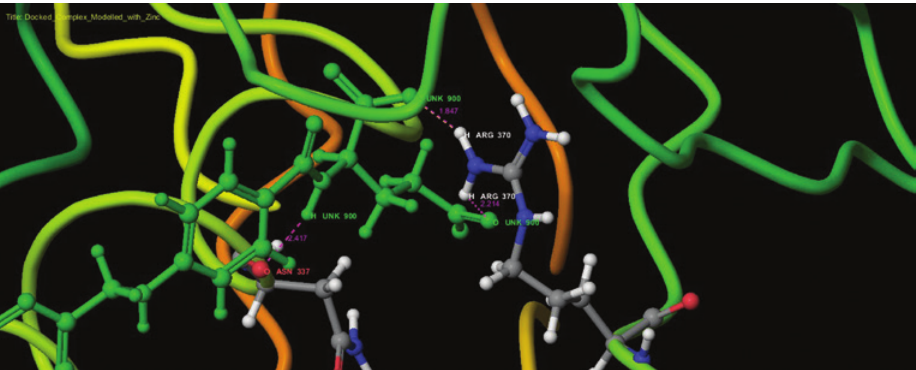
Figure 13: Interaction profile of folic acids and modeled pterin deaminase in the functional site as ribbon